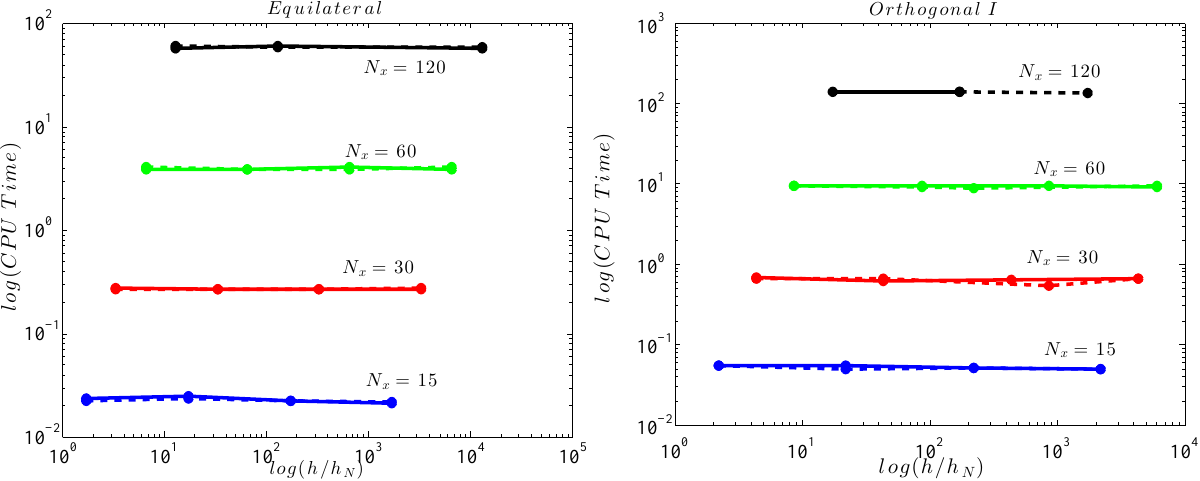
Figure 9. CPU time versus h / h N for GMRES (solid line) and BiCGStab (dashed line) using the ILU( k ) preconditioner and CMK